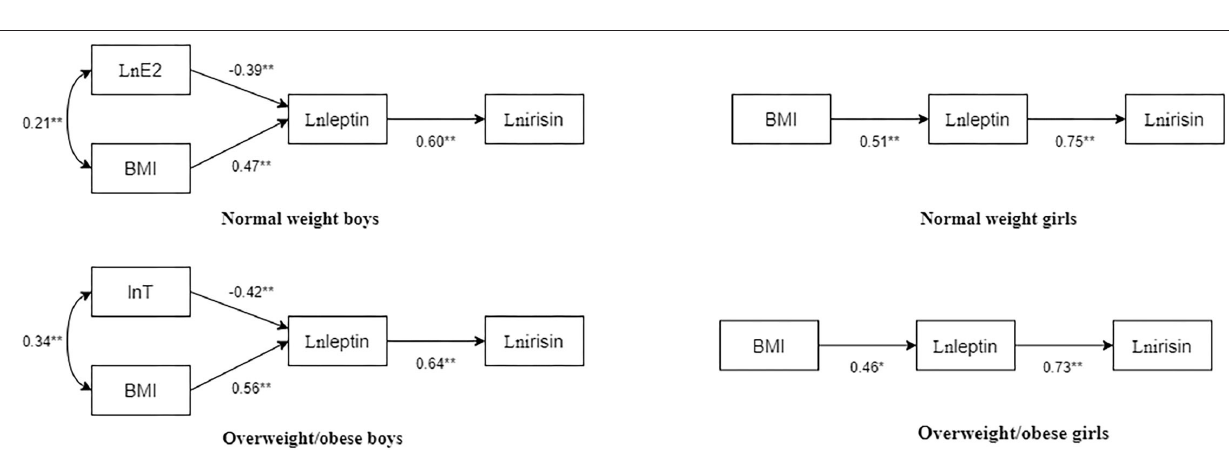
FIGURE 2 | Path diagram of BMI, T, E2, leptin, and irisin in children and adolescents with different body types. The numbers beside the arrows show the standardized path coefficients; * p < 0.05; ** p <